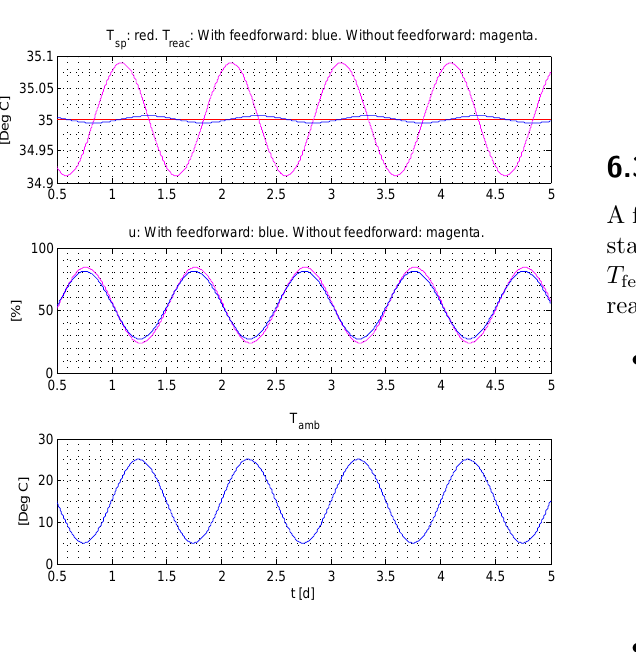
Figure 12: Simulation of temperature control with and without feedforward control, with feedback PI control in both cases.